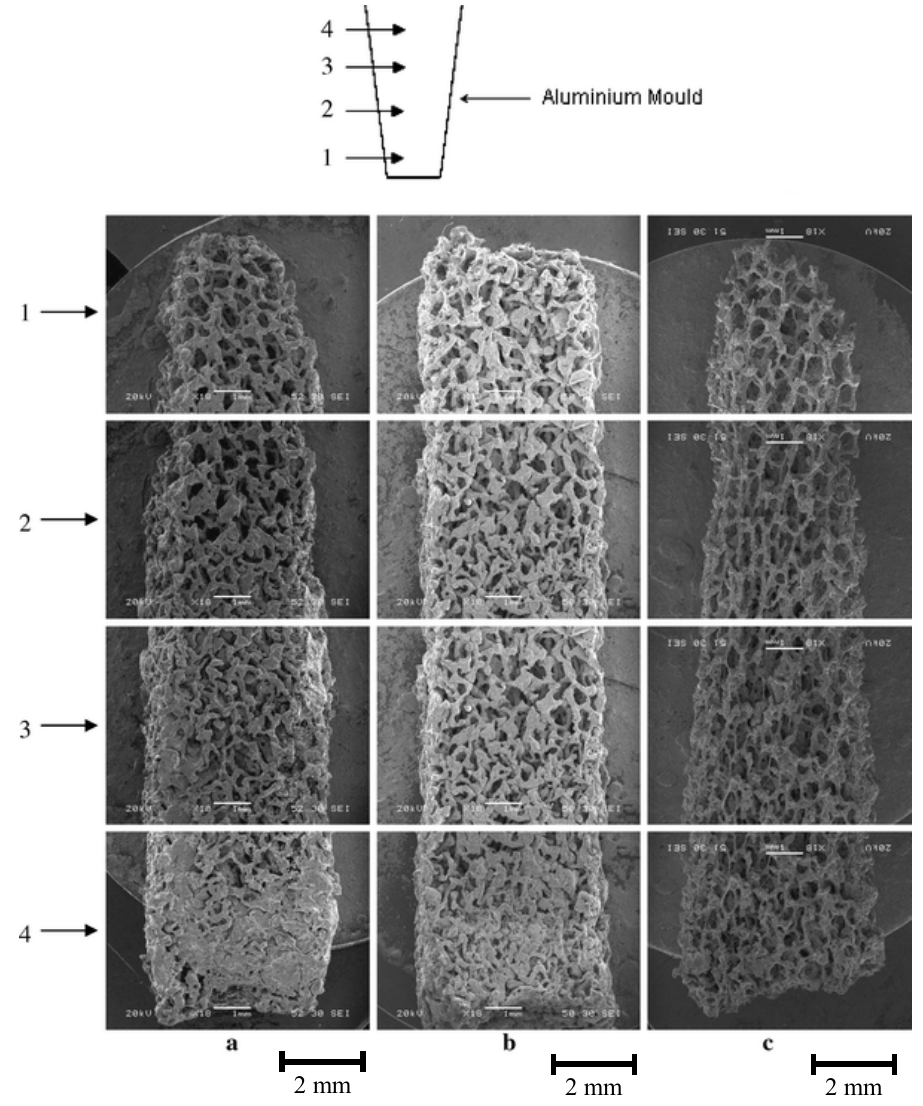
Figure 5. SEM images of scaffolds with 3D continuous porosity gradient after sintering at different degrees of compaction in aluminum mould: (a) 75%, (b) 65%, (c) 50%. Reprinted from ref. [103], with permission from Springer